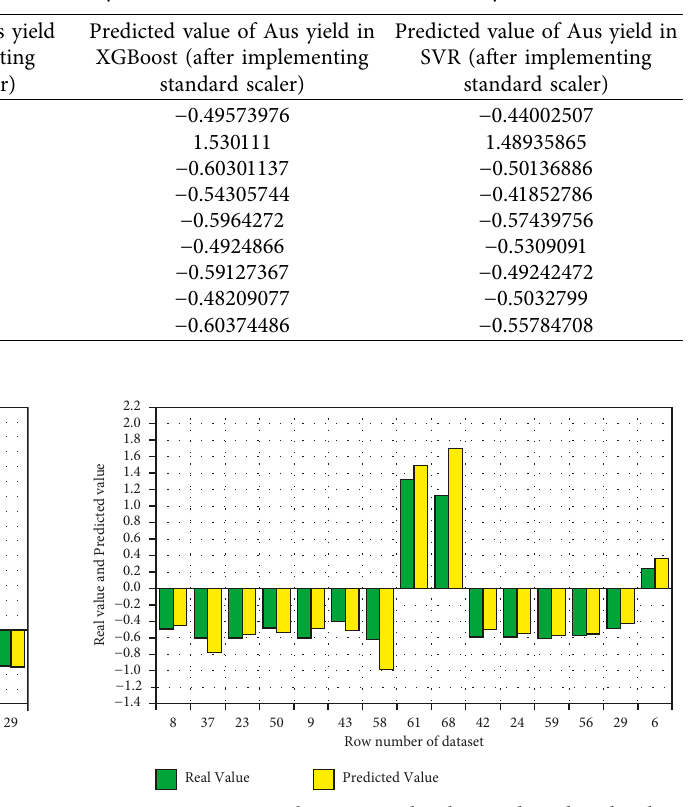
Figure 8: Comparison between Real Values and Predicted Values of Aus yield for XGBoost.